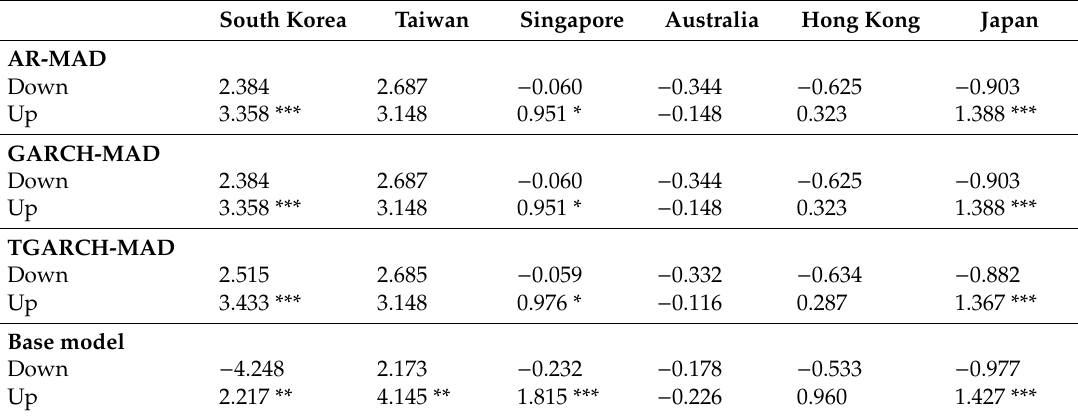
Table 8. Robustness check of sub-period VAR